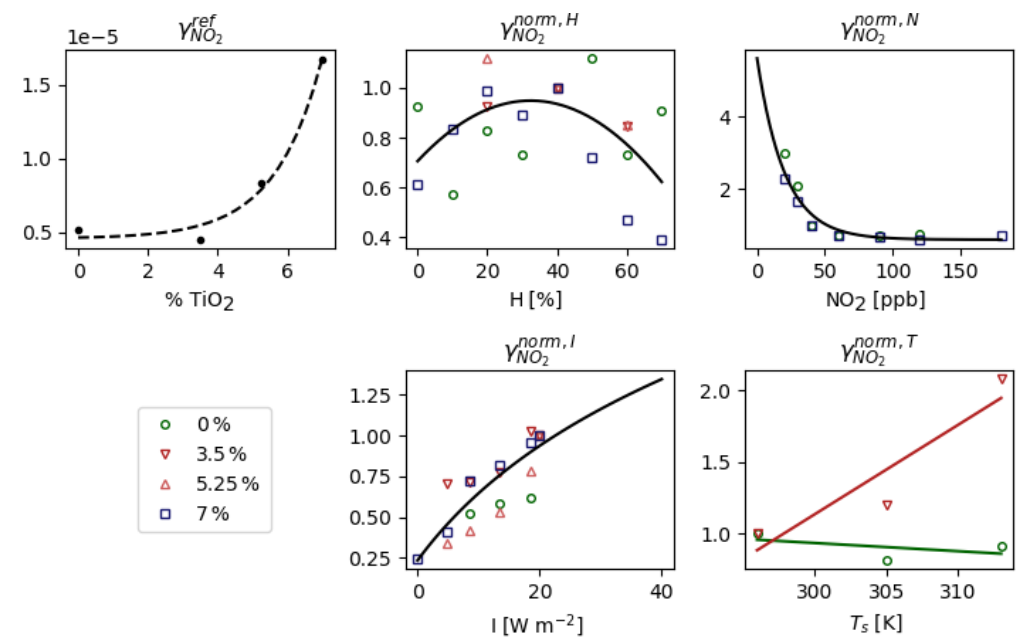
Figure 3. Evolution of γ NO . The dots denote measurements, and the open symbols denote normalized measurements (see text for details). 2 The solid lines denote the parameterization as a function of H , N , I and T s (Eqs.